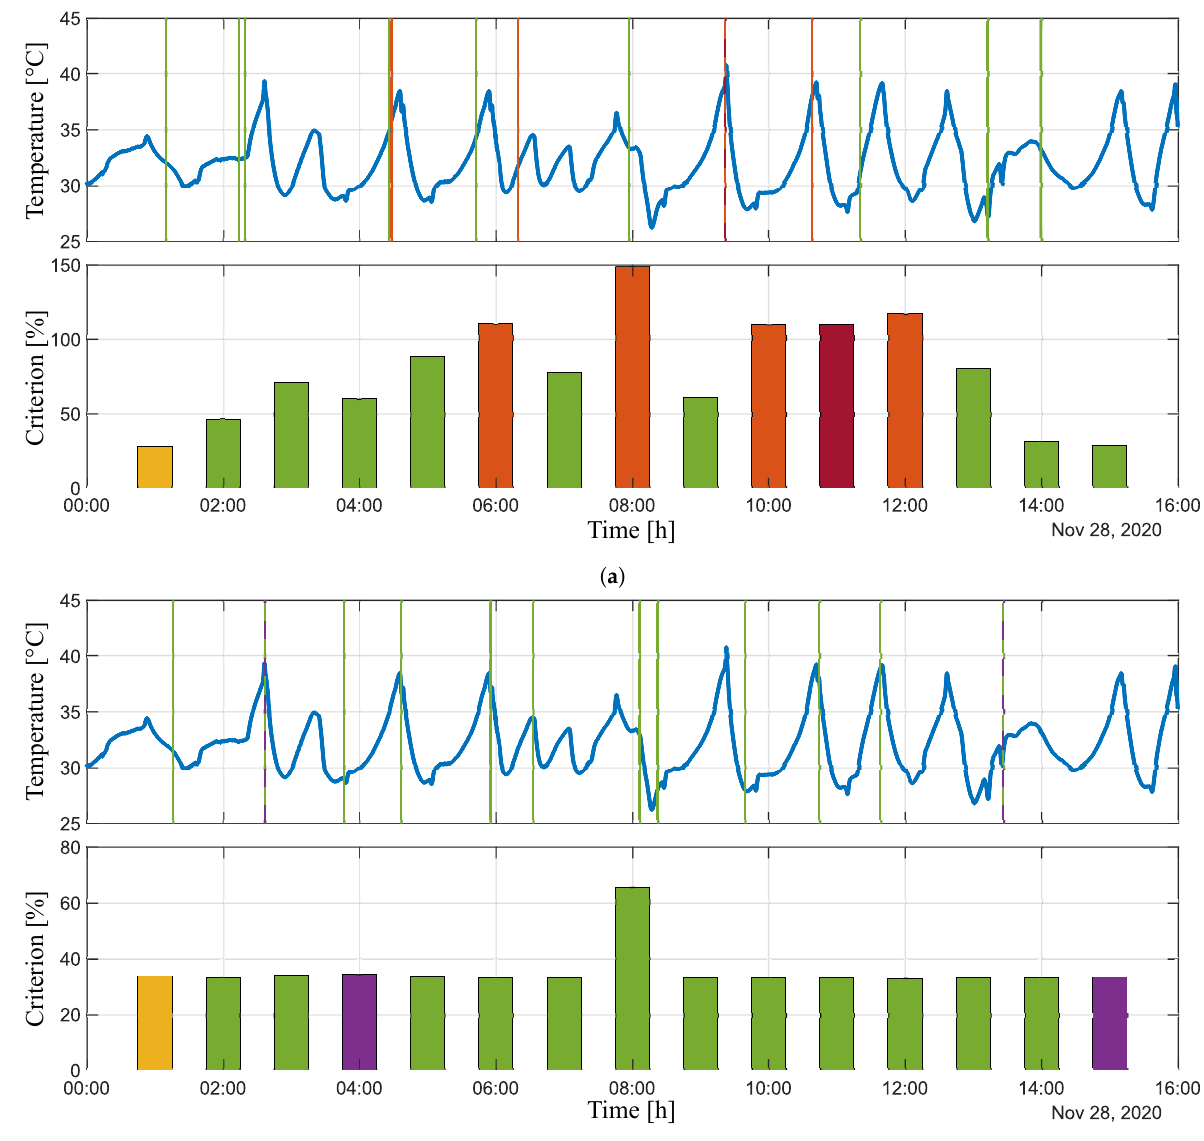
Figure 6. Experimental results of cfn:: TC T15.3_out0 variable. ( a ) Signal evaluation and oscillation analysis. ( b ) Signal evolution and sudden change